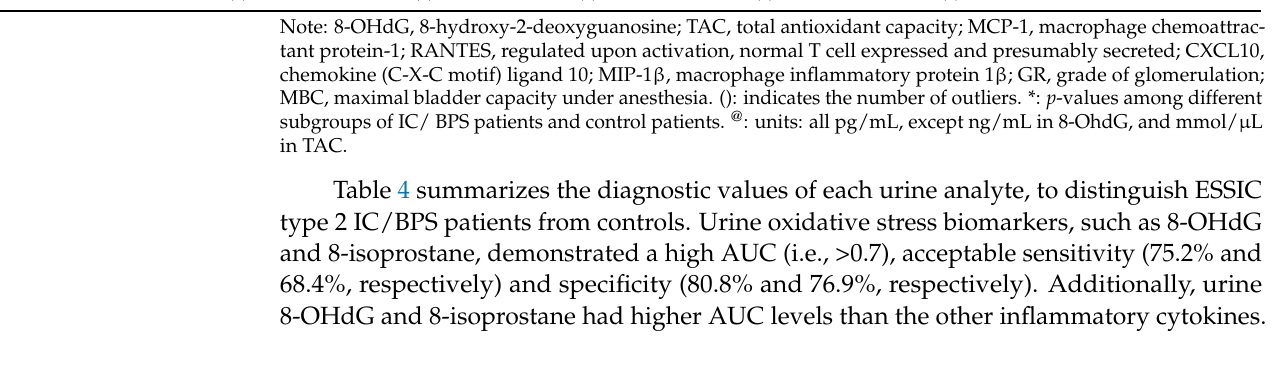
Table 4. Diagnostic values of urine biomarkers in patients with ESSIC type 2 IC/BPS (from